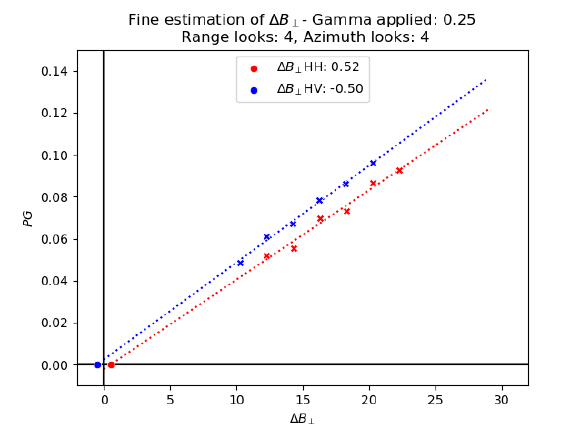
Figure 8. A subset of the coherence maps for pair #2. HV is much noiser than HH and this has an impact on the orbital cor- rection